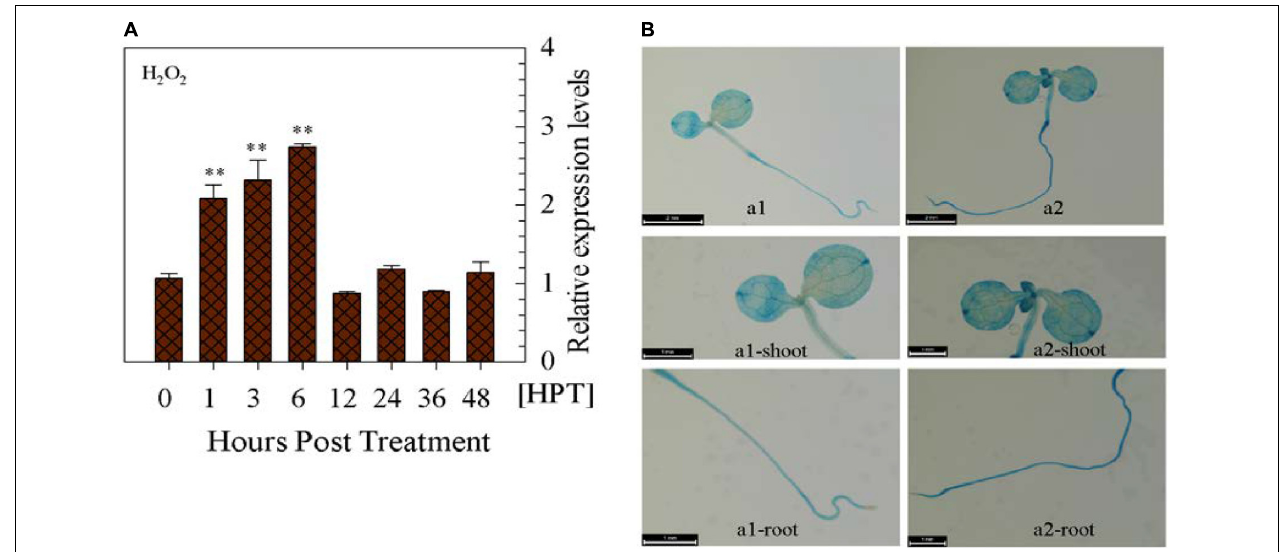
FIGURE 7 | CaWRKY27 gene expression was induced by exogenously applied H 2 O 2 in pepper plants. (A) CaWRKY27 expression in the leaves of WT pepper plants treated with H 2 O 2 as determined by qRT-PCR. Relative CaWRKY27 expression levels were compared between H 2 O 2 -treated pepper plants and mock-treated control plants, which were set to a relative expression level of ‘1.’ Data represent the mean ± SE of three biological replicates, and asterisks indicate significant differences compared to control plants ( SNK -test, ∗ P < 0.05 or ∗∗ P < 0.01). HPT, hours post treatment. (B) Seedlings carrying the pCaWRKY27::GUS construct were treated with H